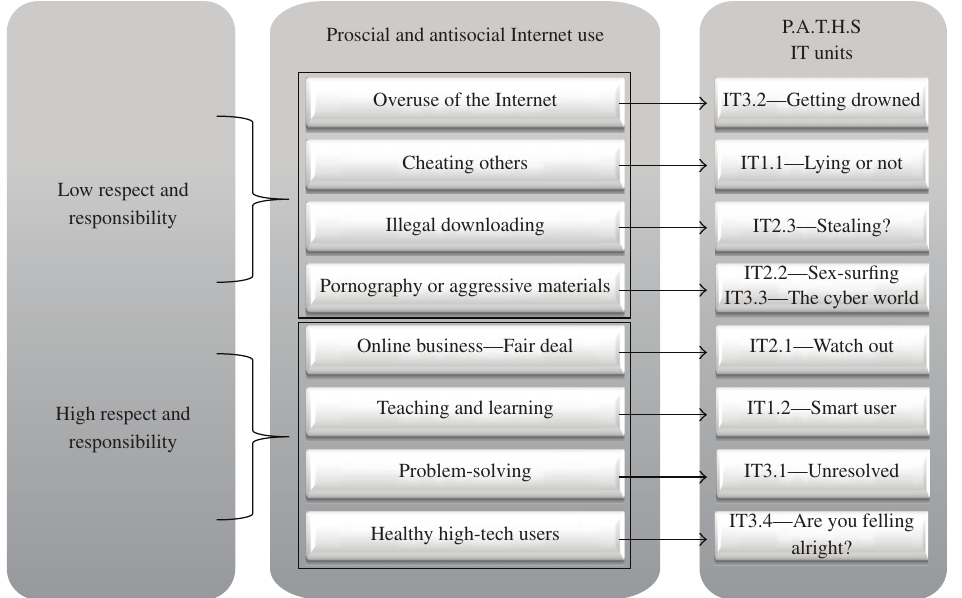
FIGURE 2: Educational implications of the Internet Use